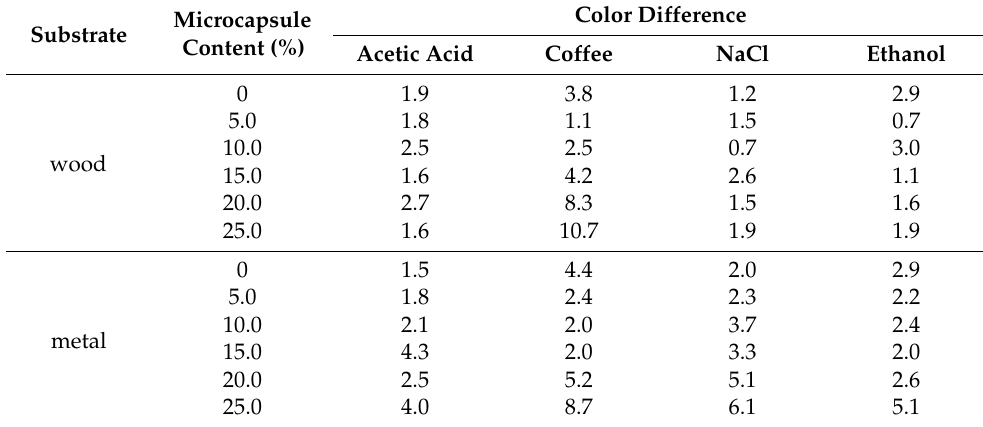
Table 10. Color difference of the coatings before and after cold liquid resistance test.